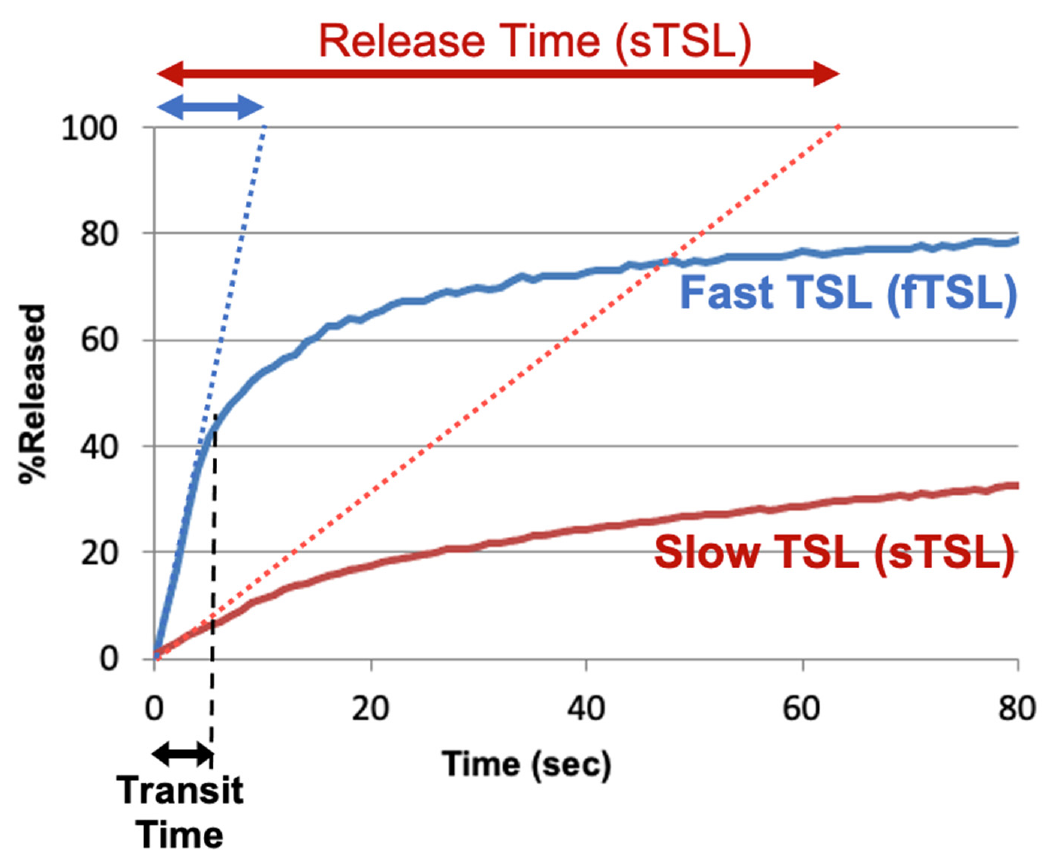
Figure 7. TSL release time. Release of two TSL formulations encapsulating a fluorescent drug analog (carboxyfluorescein) with slow (sTSL) and fast (fTSL) release is plotted, based on data from a prior study [20]. The dotted lines indicate a linear approximation of the release kinetics. TSL only spend a few seconds within the heated tumor (see black double arrow indicating ‘Transit Time’). Thus, in most cases, a linear approximation adequately represents release within those few seconds that TSL spend within the tumor vessels. Based on this linear approximation, a characteristic ‘release time’ is determined (indicated by red and blue double-arrows at the top) that enables the comparison of different TSL formulations. This release time was 8.2 s for fTSL, and 63.0 s for sTSL. The fraction of drug released during transit can be estimated by the ratio of transit time to release time (see Supplementary Material File S1, Equation